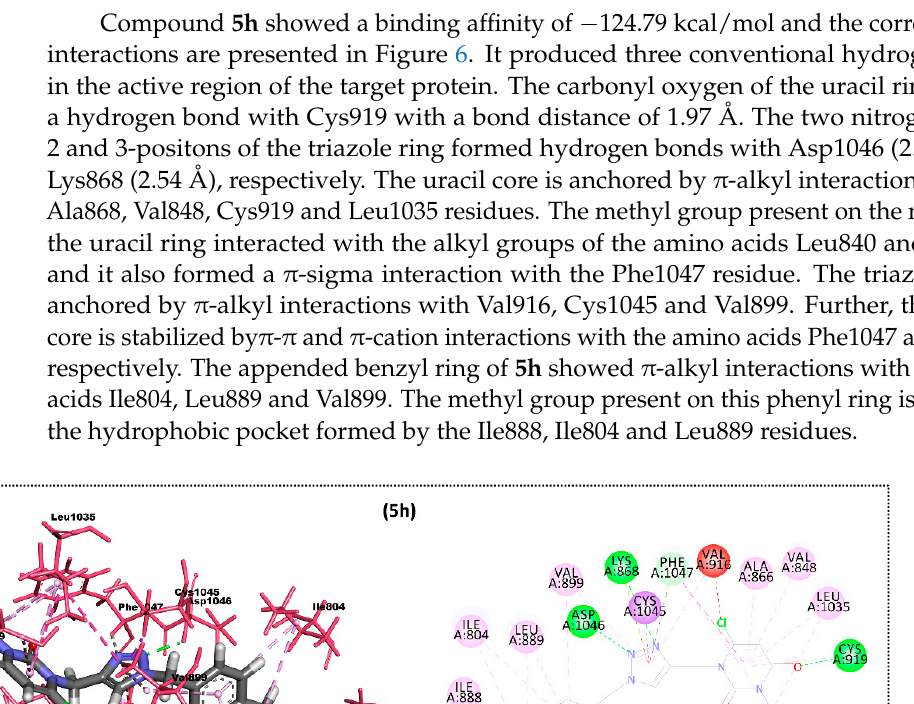
Figure 5. Docking interactions (3D & 2D) of 5f with the receptor protein, VEGFR-2 transferase. Critical amino acid residues are shown in the stick model and pink colour.